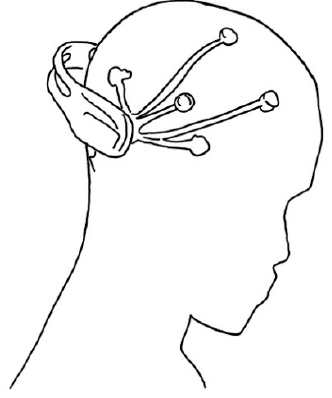
Figure 8. Head-mounted EEG